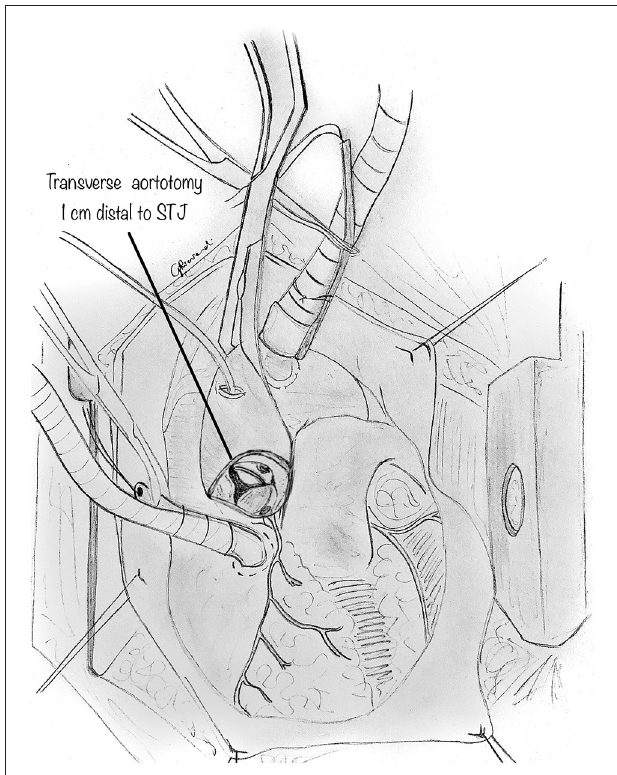
FIGURE 2 | Following a cardioplegic arrest of the heart, a transverse aortotomy is made above the sinotubular junction. The aortotomy is then extended parallel to the annulus of the aortic valve, directed to the left inter-coronary commissure. Additional care must be paid in case of high intramural course of proximal tract of the coronary, to avoid accidental lesions to the anomalous